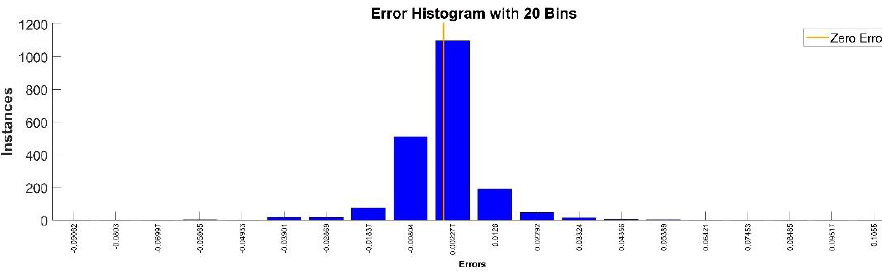
Figure 18. Error histogram between the target values and the estimated values for q 3 .